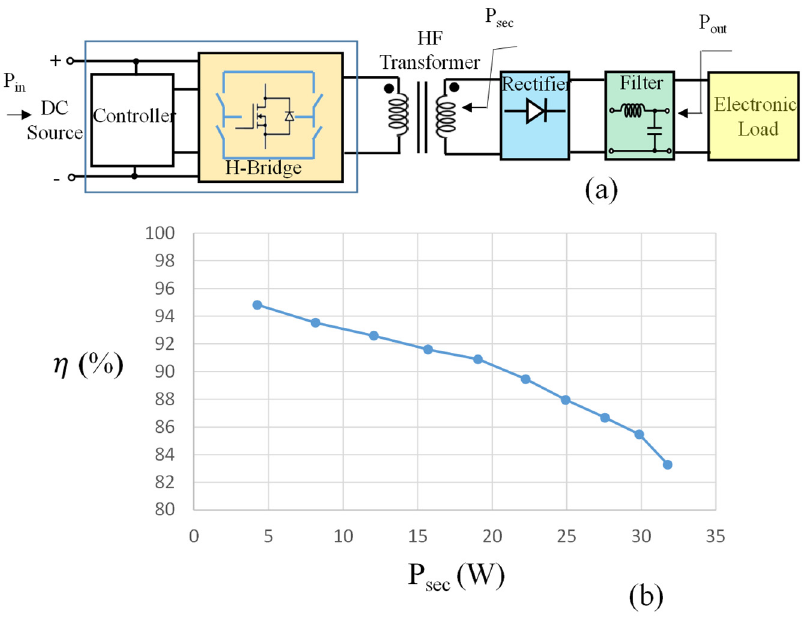
Figure 22. ( a ) Measurement circuit setup. ( b ) Efficiency versus power variation on the secondary path of the main HF transformer. path of the main HF